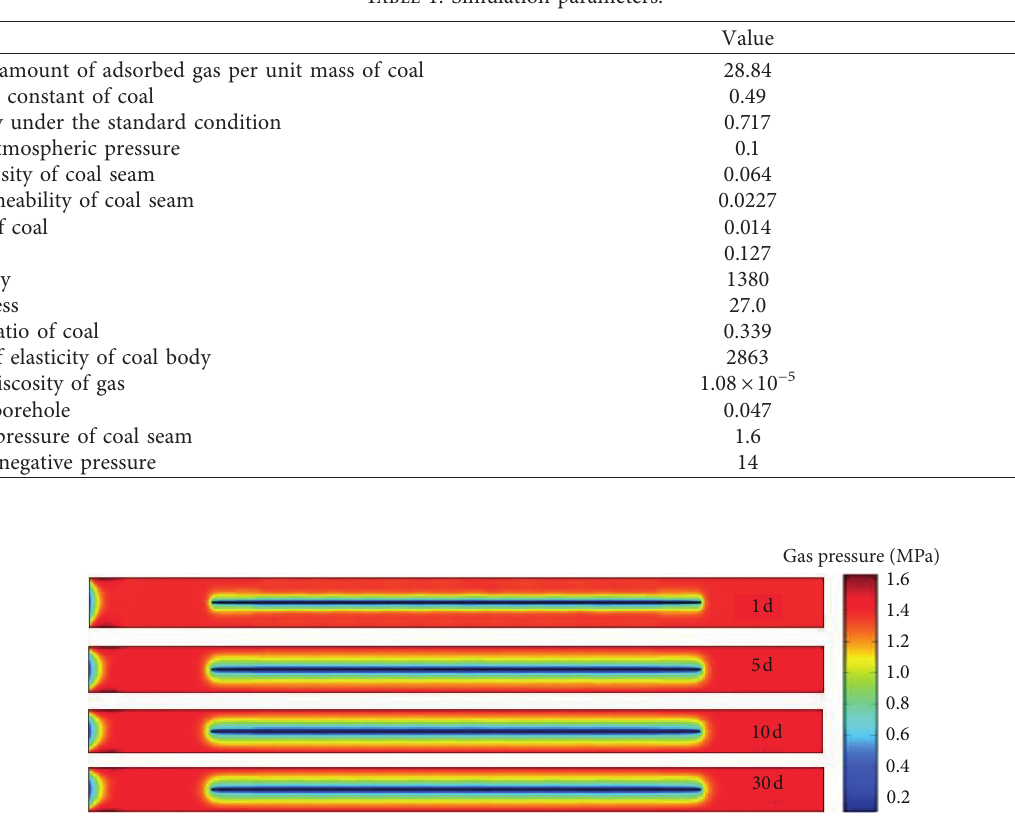
Figure 5: The gas pressure distribution of complete hole in the coal